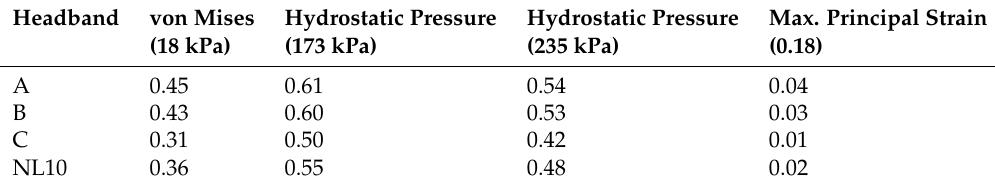
Table 10. Brain volume percentage where the injury thresholds were